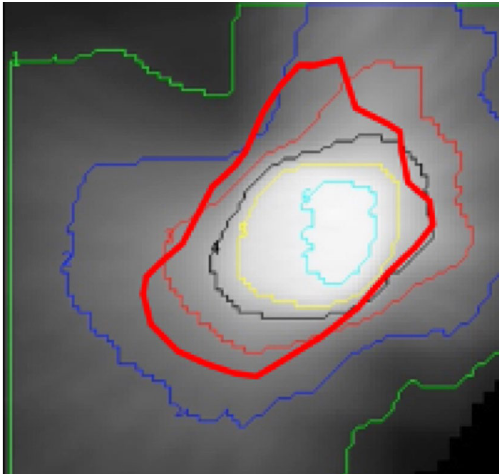
Figure 3. Robustness to error in image registration: the effect of mis-registration on the dose–response D 50 and γ 50 outcomes. Shown is the 3-dimensional dose field for an SBRT target, with isodose contours overlaid onto the gray-scale dose image. Registration error results in a shift of the d 50 contour (bold red curve). Since the new D 50 estimate is the average dose along the bold red curve and the new curve crosses both higher and lower dose regions, the d 50 value may not change dramatically. However, since γ 50 represents the heterogeneity in response along the D 50 contour, its value is very sensitive to registration